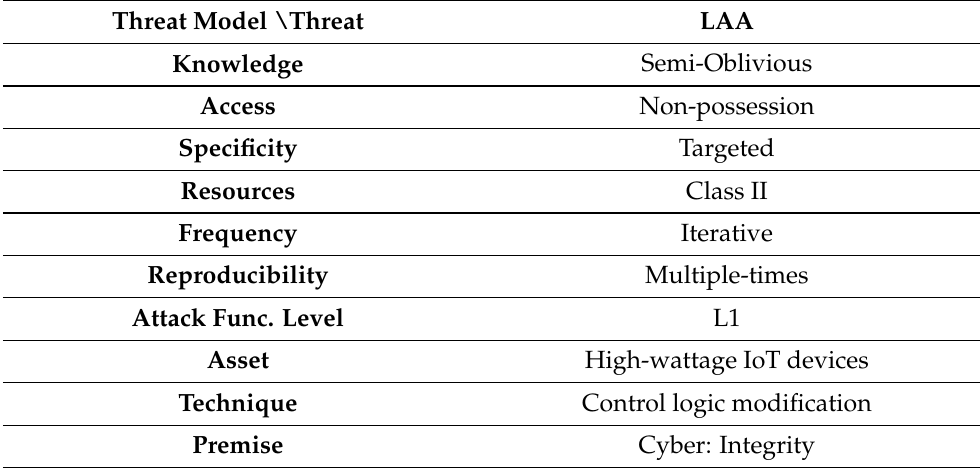
Table 1. Threat model for